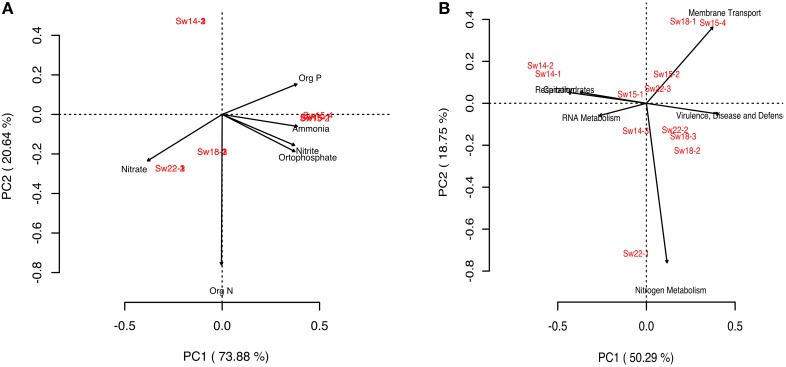
Principal component analysis (PCA) diagrams. (A) Diagram generated for the bacterioplankton samples and nutrients in seawater. (B) Diagram generated for the bacterioplankton samples and metabolisms in seawater.